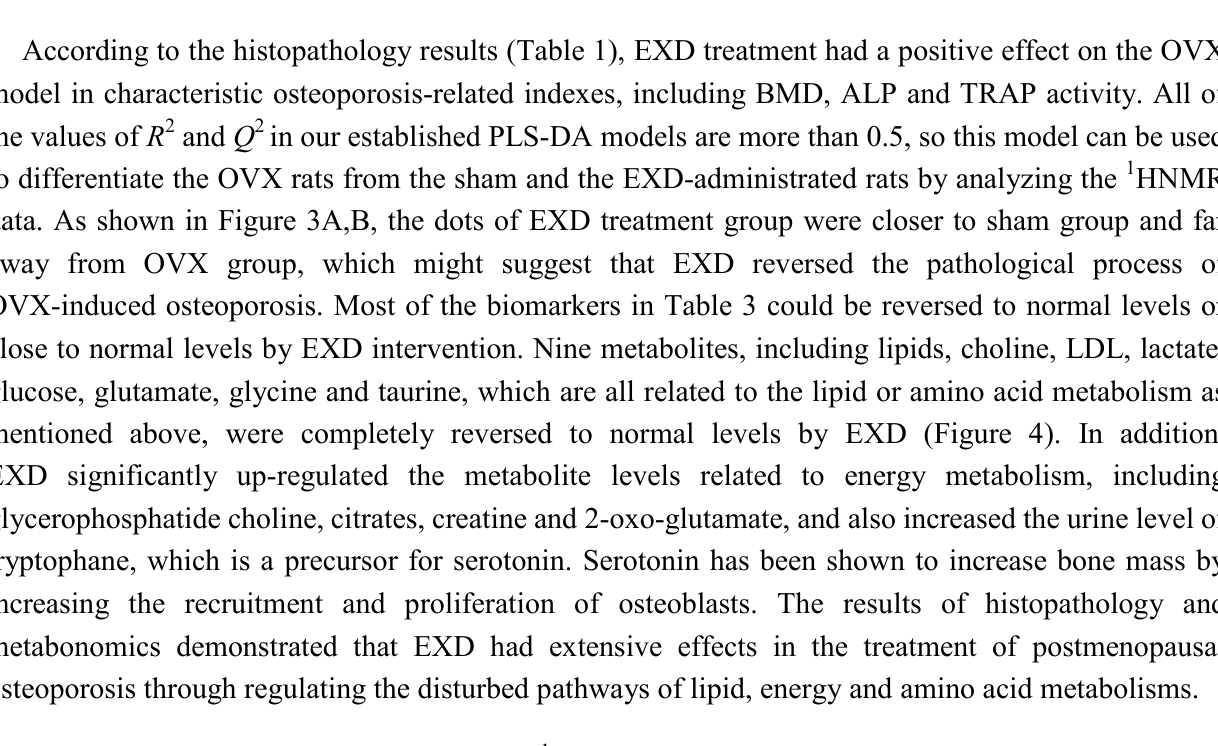
Figure 3. Scores plot from PLS-DA of 1 HNMR data of urine ( A ) and plasma ( B ) samples obtained from control rats, OVX rats and EXD treatment